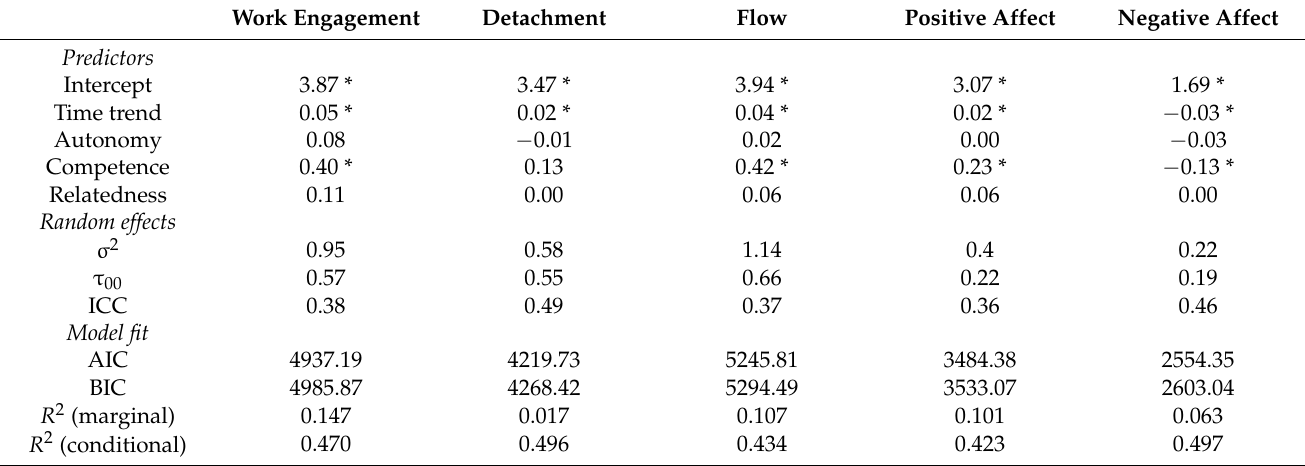
Table 5. Multilevel model of change for the once-daily assessments of work engagement, detachment, and flow, as well as positive and negative affect. The time trend describes the linear trend over the 10 workdays/2 weeks the study spanned, and the levels of autonomy, competence, and relatedness are those reported for work from home. n = 1652 observations, clustered in 192